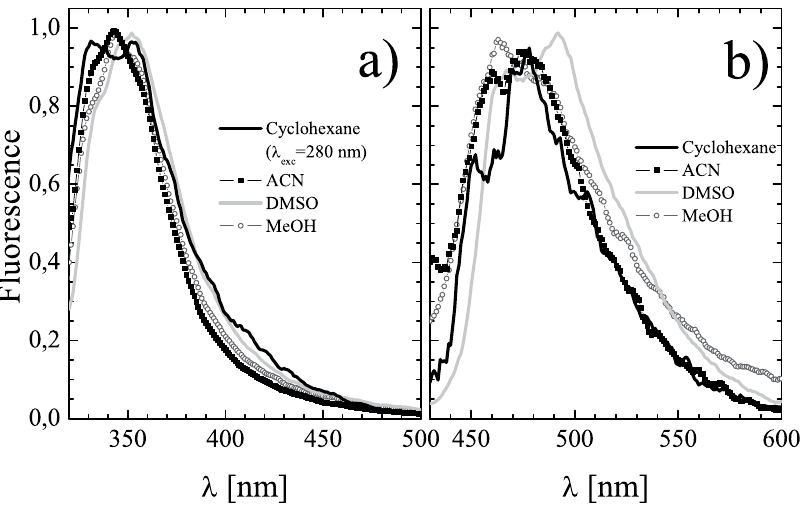
Fig 5. Fluorescence emission properties of K2T23. Emission spectra obtainedupon excitationat a) the diketo, and b) the keto-enol, absorptionpeaks for K2T23 dissolvedin cyclohexane (line), acetonitrile (squares), dimethylsulfoxide (crosses), and